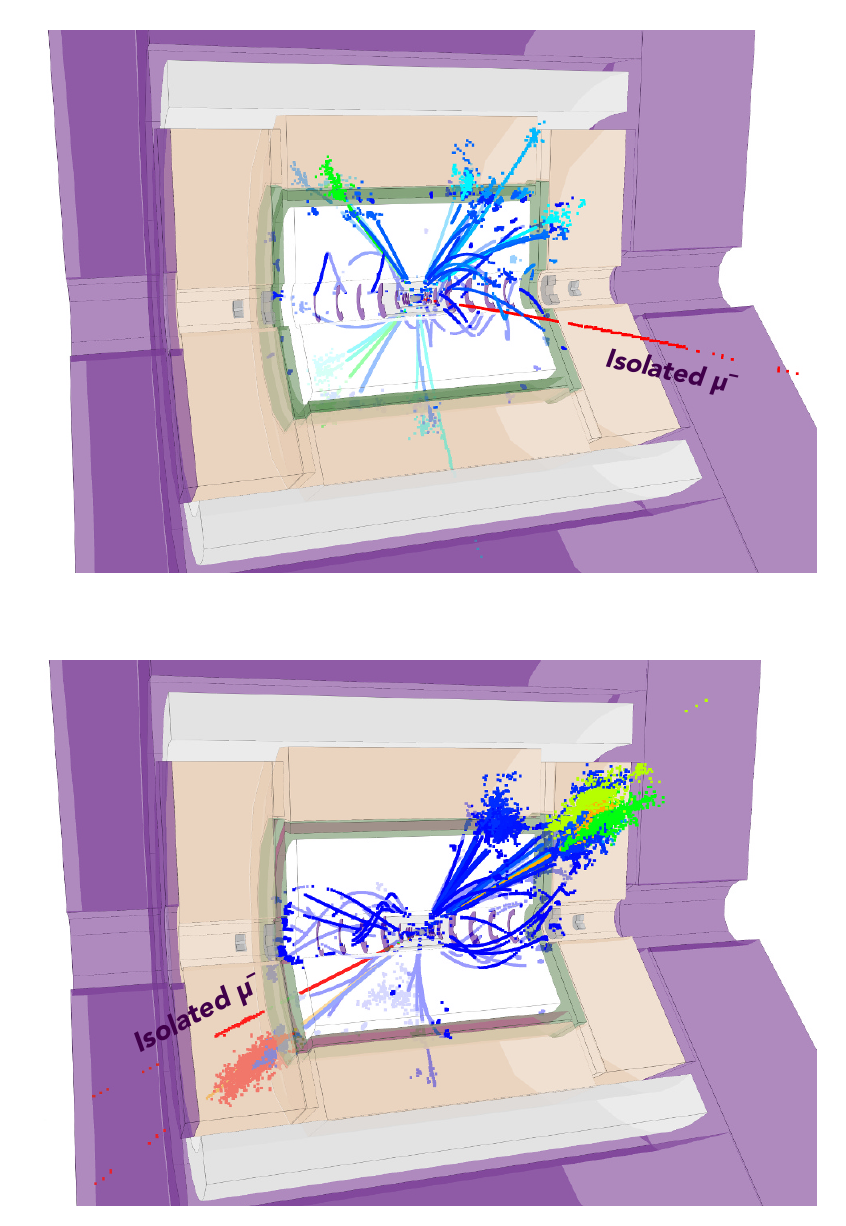
Figure 20. Example displays of tt ! qqqq mn p s = 3 TeV (bottom). The events include overlay of gg ! hadrons background as described in subsection 5.2. An isolated lepton is clearly seen along with four separate jets (top) or two larger boosted jets (bottom).